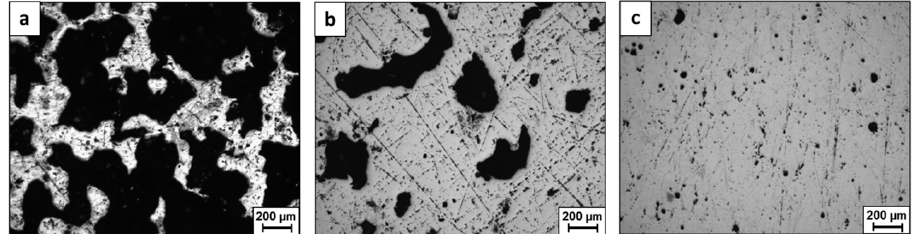
Figure 9. Macroscopic structure by optical microscopy of HEA VNbMoTaW obtained by various LPBF trials using mix elemental powder: ( a ) LPBF—Primary trials, ( b ) LPBF—Intermediate trials,